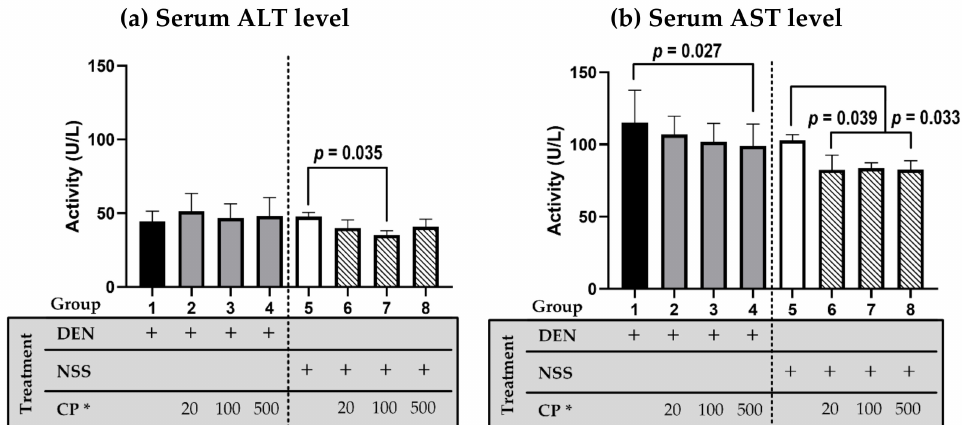
Figure 2. The effect of CP on the serum level of ALT ( a ) and AST ( b ). DEN or NSS were initially administered at week 0 and 1. Then either DW (for groups 1 and 5) or CP were fed weekly starting from week 2 till the end of the experiment. Data was distributed normally (Shapiro–Wilk and Levene’s tests: p ≥ 0.05) and was analyzed for statistically significant using one-way ANOVA with LSD’s post hoc test: F (ALT) = 2.243 ( p = 0.048) and F (AST) = 5.061 ( p < 0.001). * CP dosage unit; mg/kg